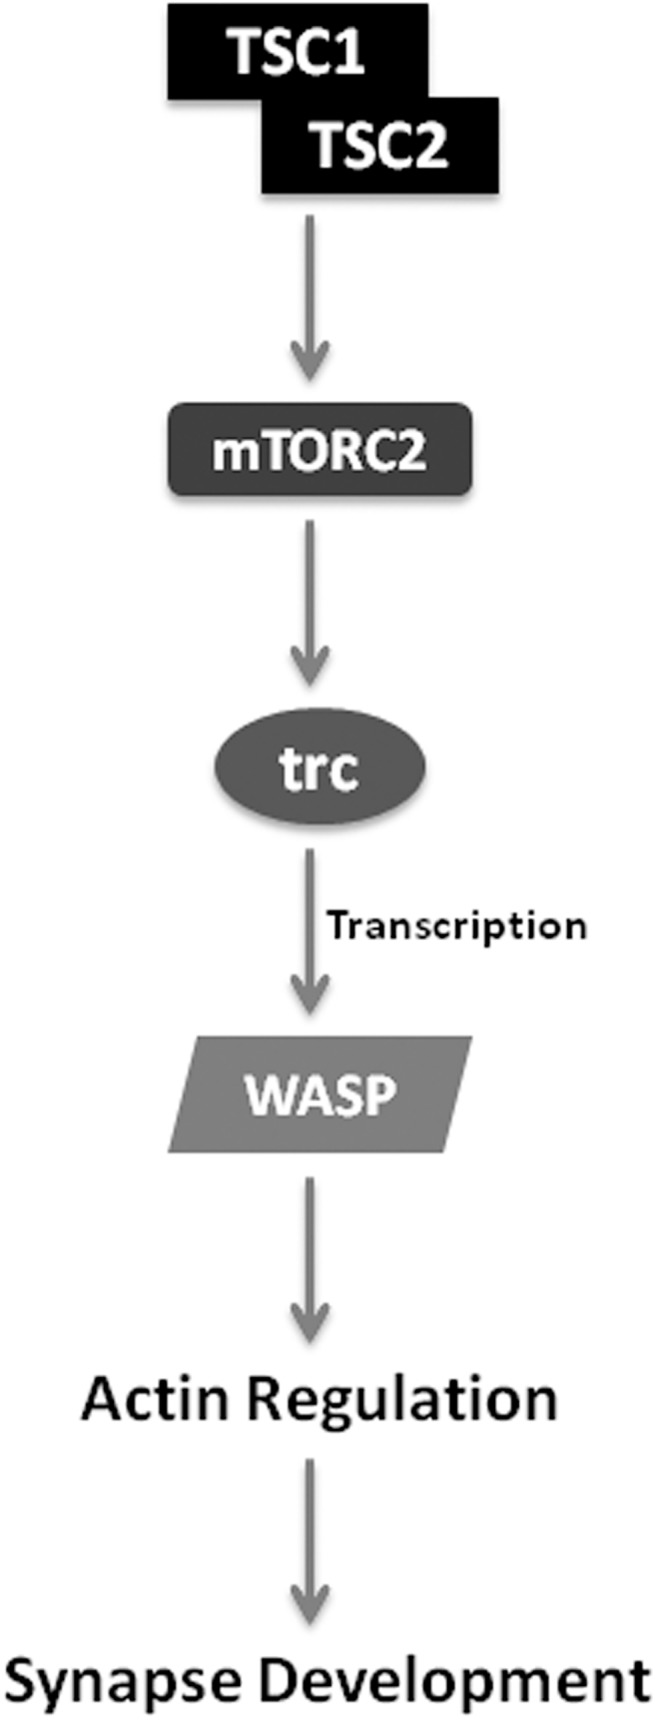
Schematic model of how Trc may regulate synapse development at Drosophila NMJ.Based on our data, Trc likely acts downstream of mTORC2 in the presynaptic compartment to regulate synaptic WASP, largely by regulating the transcription of WASP. Since WASP is known to regulate the polymerization of actin, we hypothesize that Trc ultimately regulates the actin cytoskeleton to regulate synapse development at the Drosophila NMJ synapses.